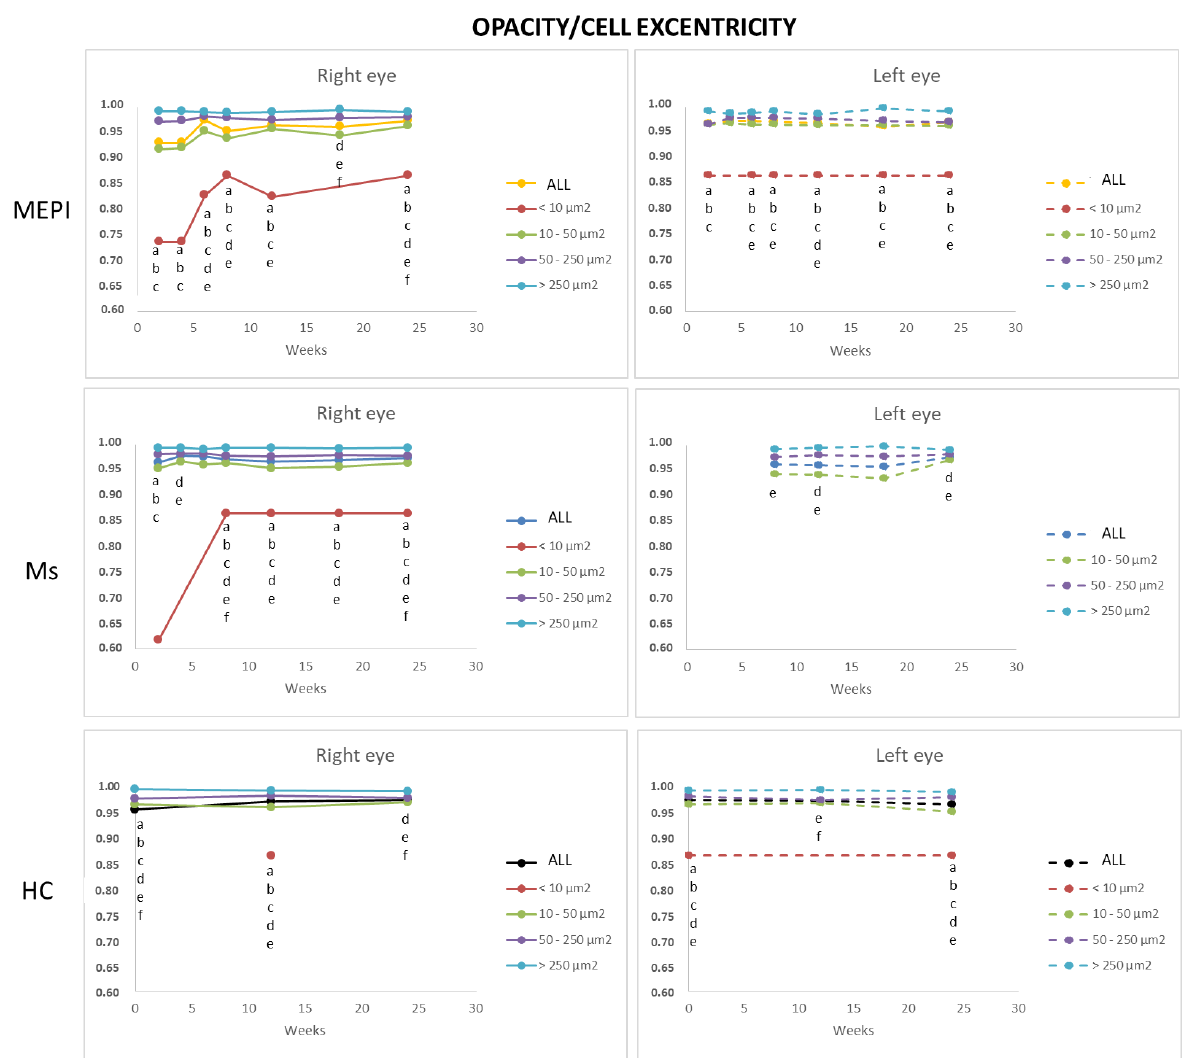
Figure 11. Mean eccentricity of vitreous opacity detected using OCT, according to size, in both glaucoma models and healthy controls. Indirect in vivo analysis of cell soma morphology. Abbreviations: MEPI: model induced by sclerosing the episcleral veins; Ms: model induced by injecting microspheres into the anterior chamber; isolated cells: opacities < 10 microns 2 (group 1); non-activated cells: 10–50 microns 2 (group 2); activated cells: 50–250 microns 2 (group 3); cell complexes: > 250 microns 2 (group 4). Statistically significant differences ( p < 0.05) were highlighted with alphabetic markers as follows: a (group 1–group 2); b (group 1–group 3); c (group 1–group 4); d (group 2–group 3); e (group 2–group 4); f (group 3–group 4).